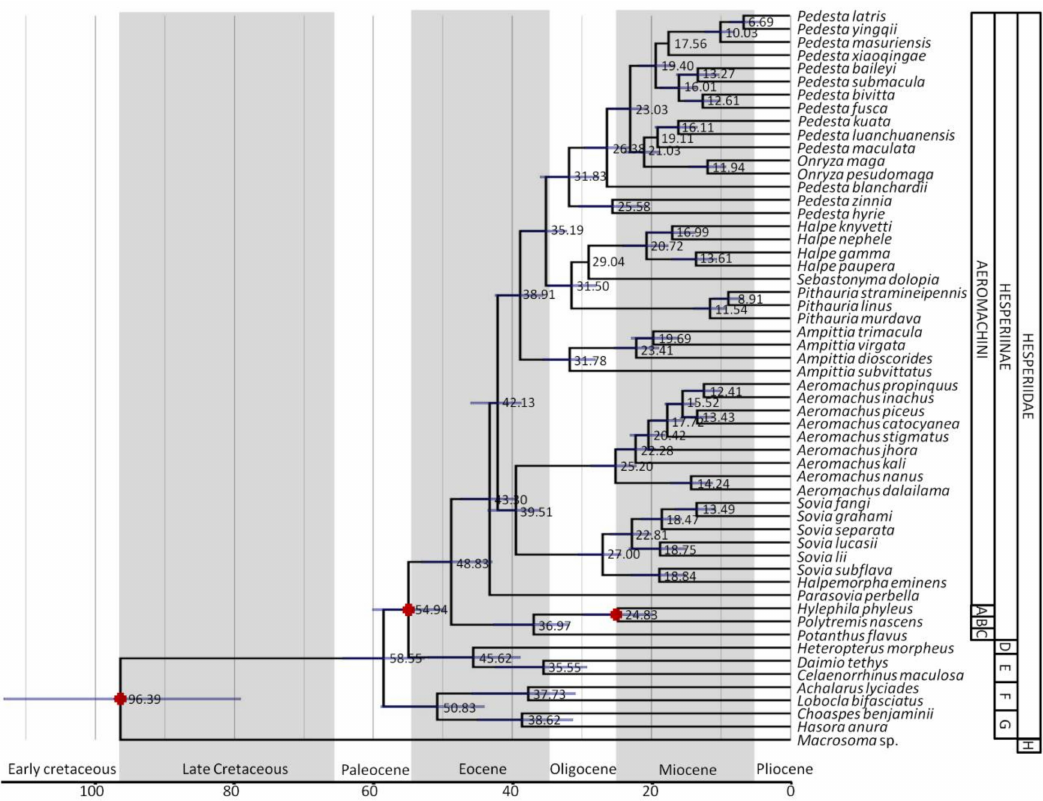
Figure 3. Chronogram of Aeromachini divergence based on mean tmrca estimates. The scale bar is in units of millions of years. Lettered nodes are those for which tmrca was estimated. A filled star denotes a node for which a prior calibration was used. A, Hesperiini; B, Baorini; C, Taractrocerini; D, Heteropterinae; E, Coeliadinae; F, Eudaminae, G, Pyrginae; H,